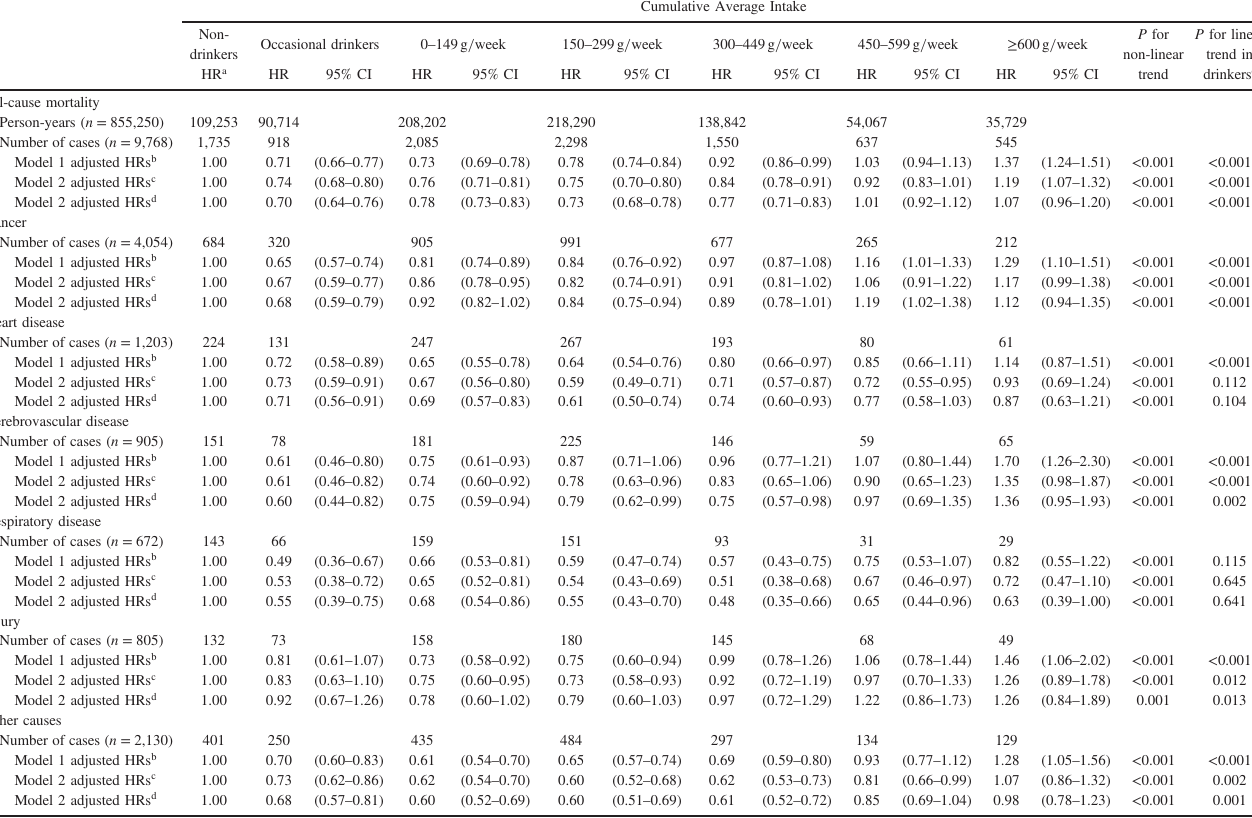
Table 2. Adjusted hazard ratios of mortality by alcohol consumption status